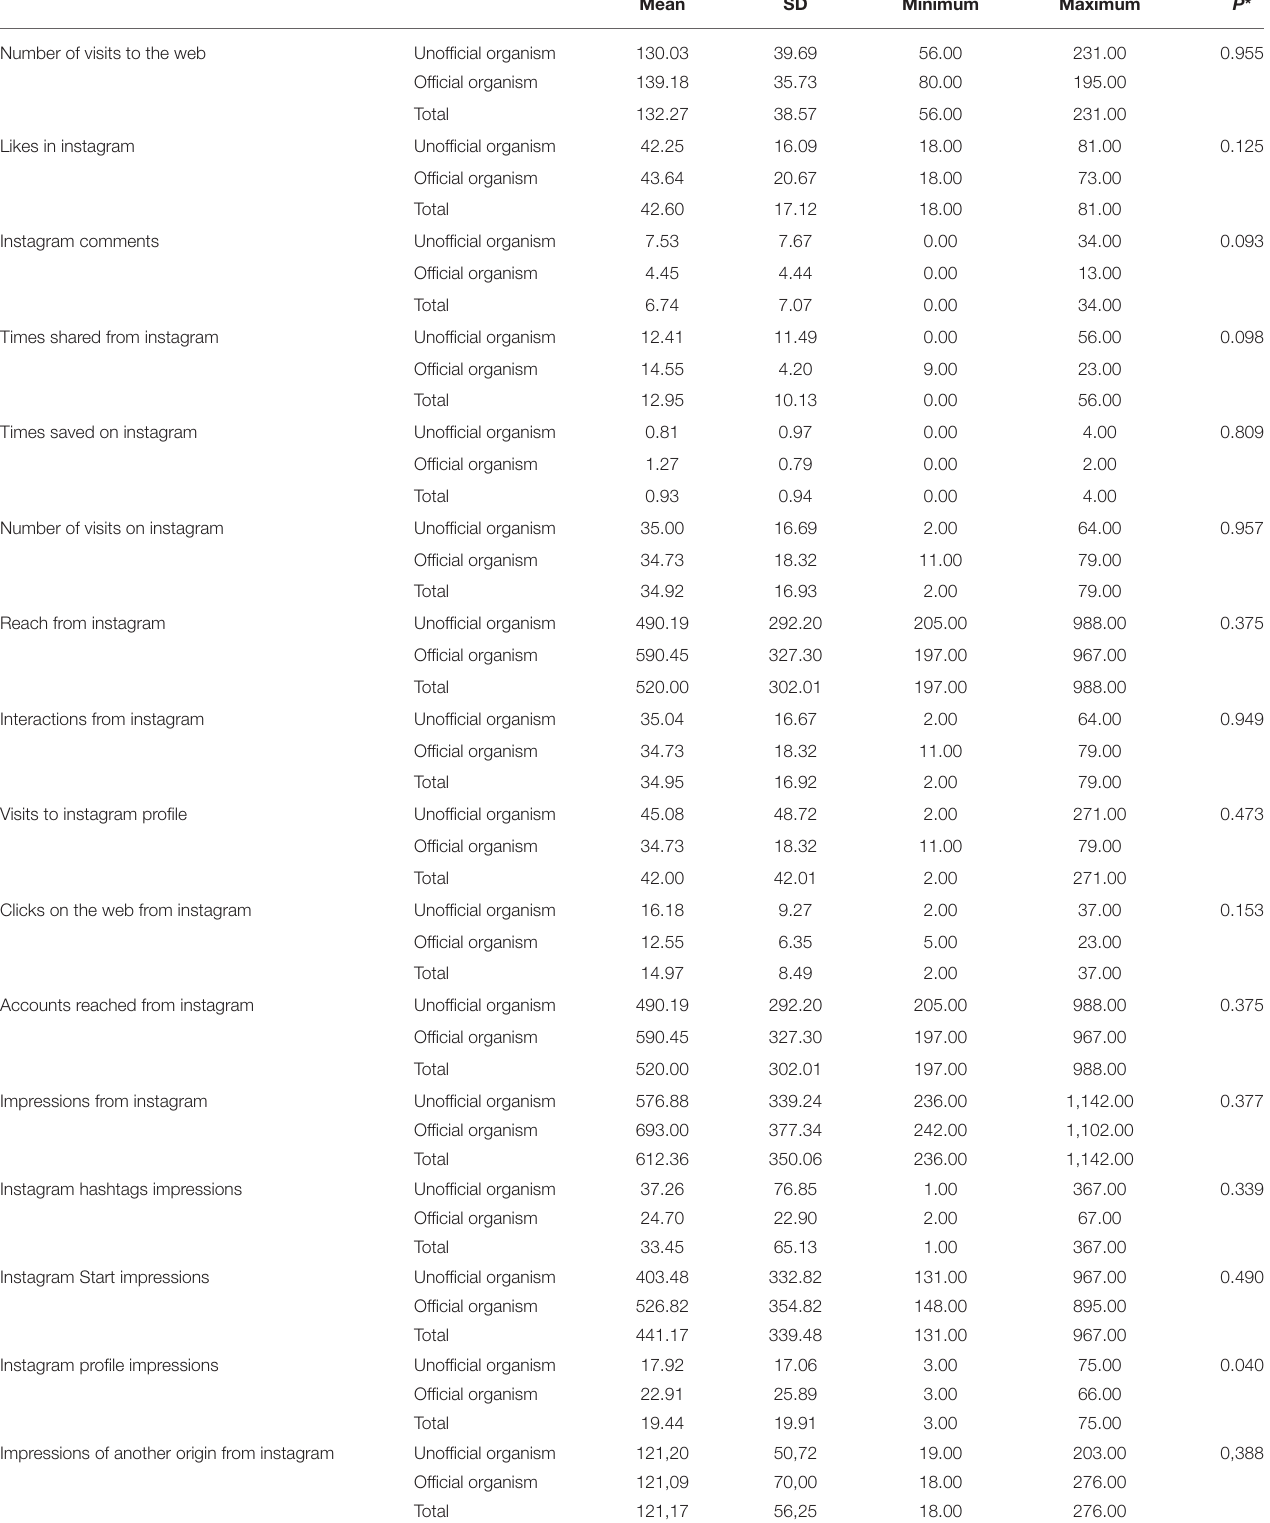
TABLE 3 | Comparison of the mean values measured on the websites according to the source of